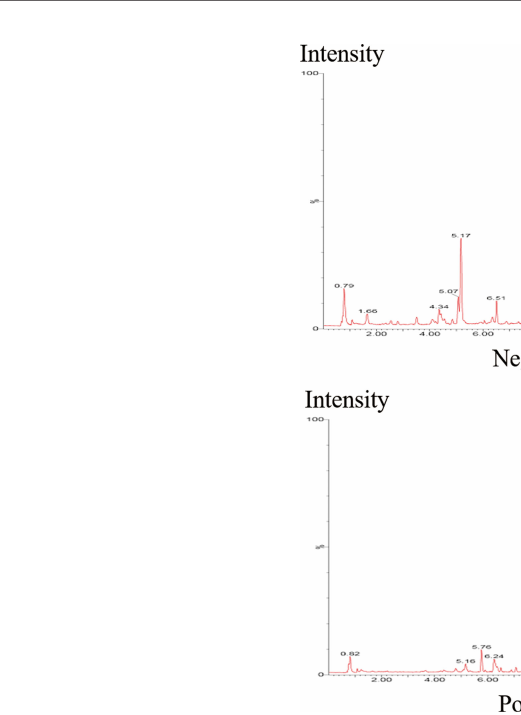
FIGURE 3 | The total ion chromatogram of MYGY-Nb in Negative and Positive ion